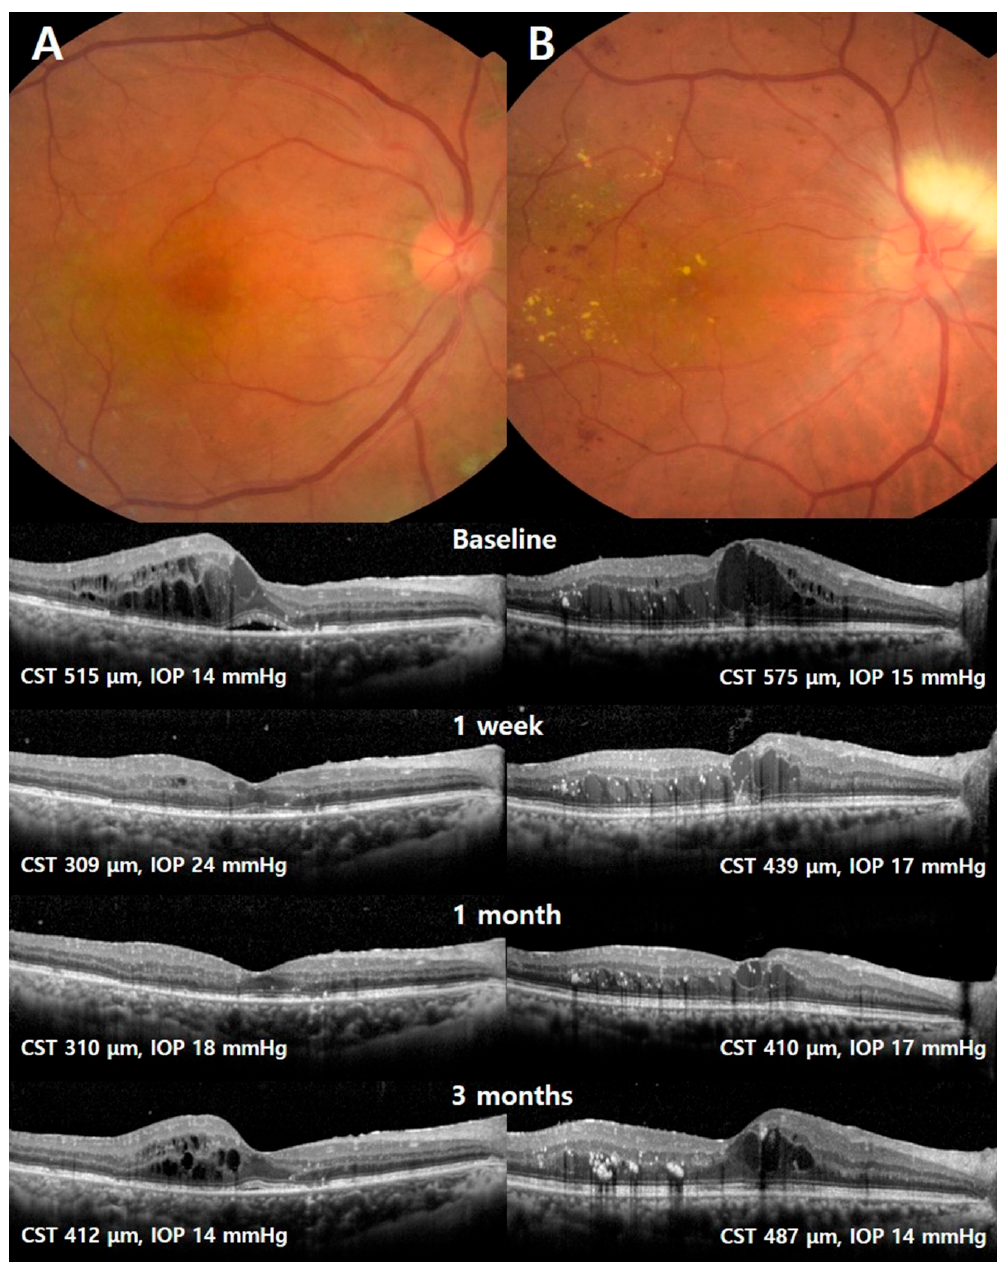
Figure 3. Fundus photographs and Optical coherence tomography (OCT) scans of representative cases from the good early anatomic responder (GEAR) and poor early anatomic responder (PEAR) groups. The left column ( A ) represents the GEAR group, and the right column ( B ) represents the PEAR group.